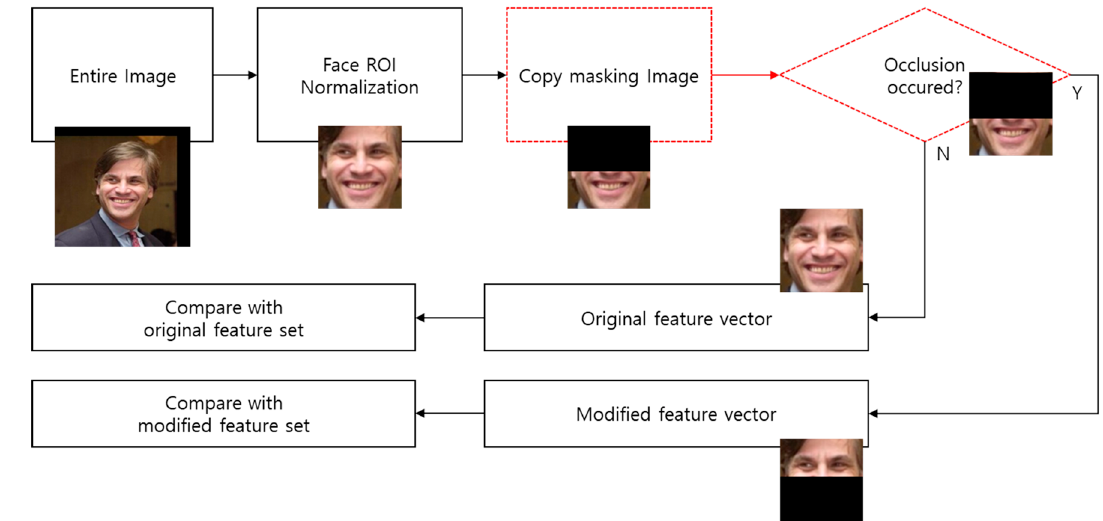
Figure 7. The entire system flow. The red dotted line is the operation unit added to the existing recognition system.